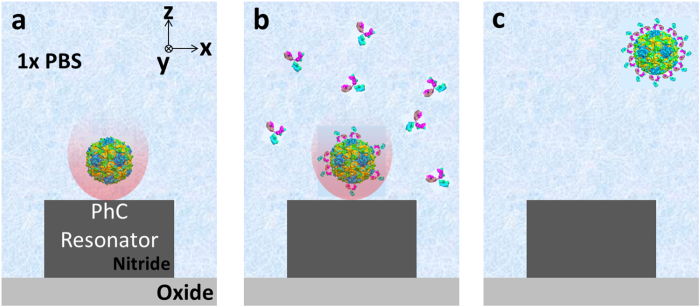
Schematics of procedure of the bioaffinity assay.The procedure involves three primary step from (a–c). (a) An influenza virus particle is optically trapped by a photonic crystal (PhC) resonator. Once the virus is trapped, an initial measurement of the trap stiffness is conducted. (b) The flow in a microchannel is switched from virus solution to antibody dispersed solution. Antibodies in the following solution bind to the trapped virus. The binding is saturated for 30 min in a stopped flow after the flow switching. (c) The second measurement of the trap stiffness after the binding is carried out. After the measurement, the antibody-virus complex is released when the laser is turned off.